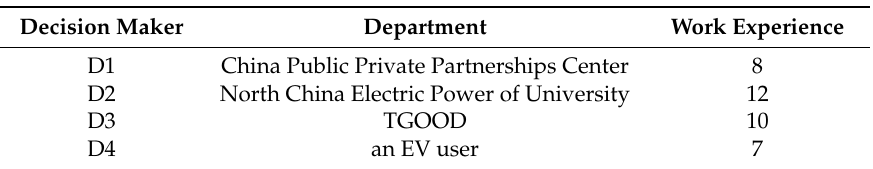
Table 2. Background of decision